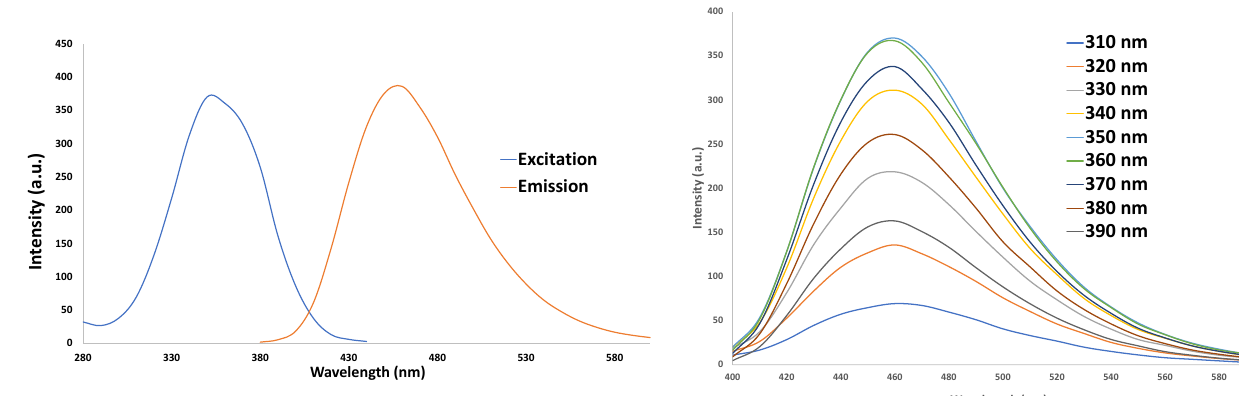
Figure 1. Characterization of CNDs. UV–VIS photoluminescence in a.u. Measurements taken by Cary ® Eclipse™ Fluorescence Spectrophotometer. Left panel: Absorption spectrum; Right panel: CNDs show emission peak of ~460 nm with excitation wavelengths from 400–600 nm.